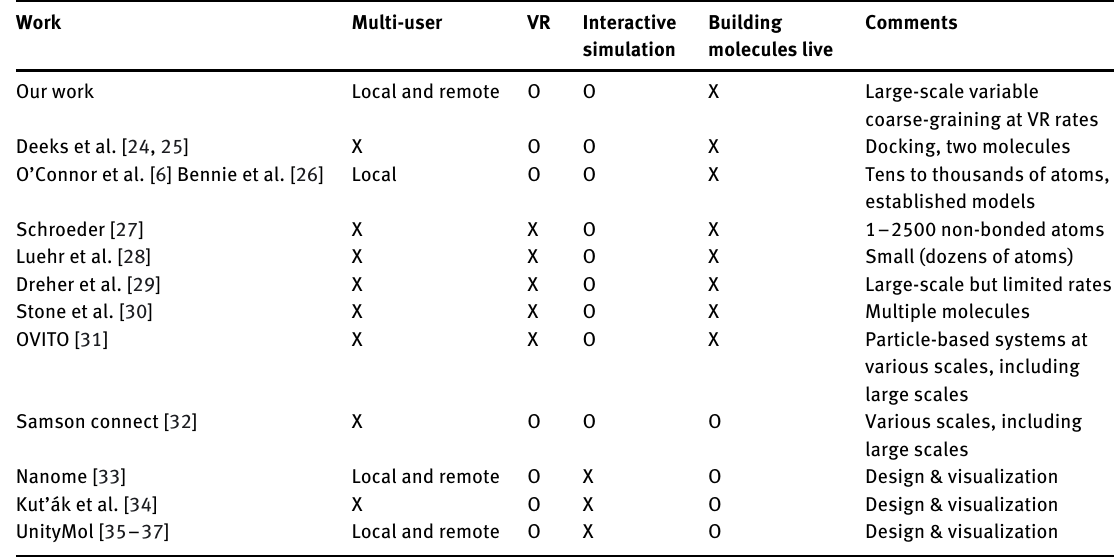
Table 1: High-level overview of several interactive molecular systems. ‘‘Large-scale’’ indicates scales on the order of hundreds of thousands or more atoms or particles.